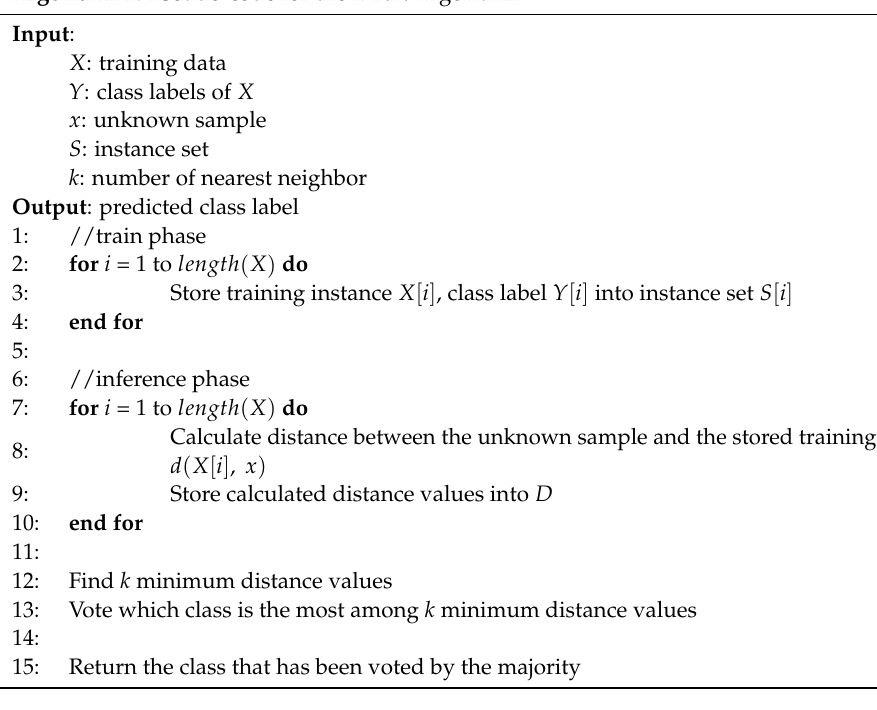
Algorithm 1. Pseudo-code for the k-NN